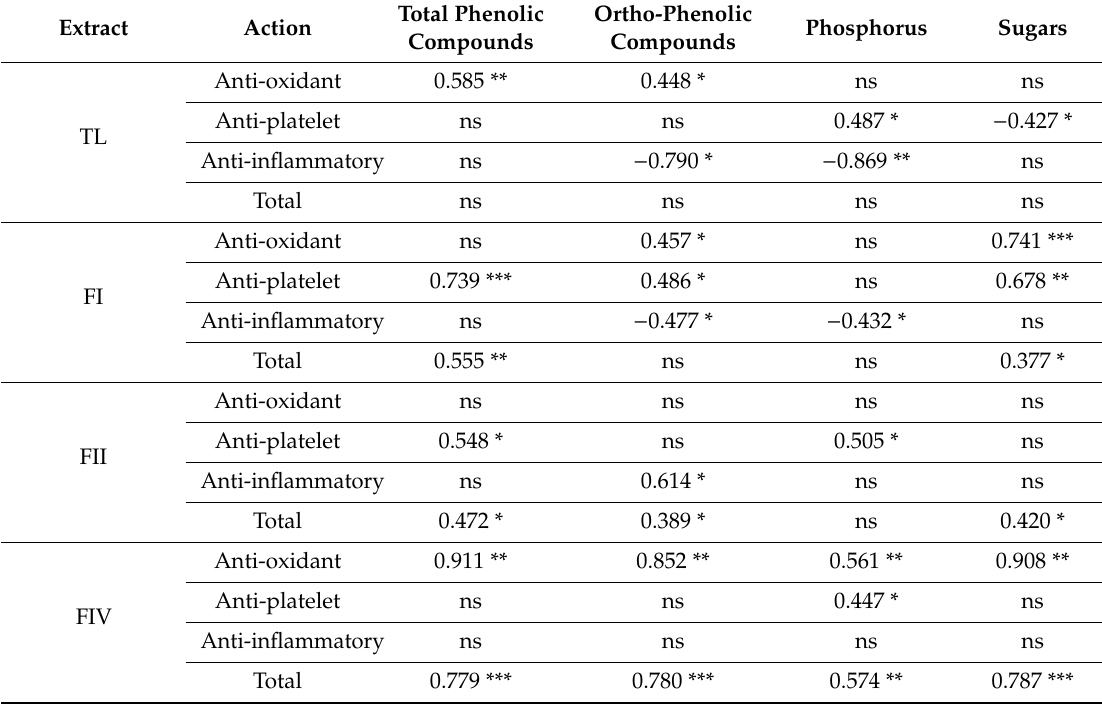
Table 6. Correlations of chemicals determinations and biological scores per type of